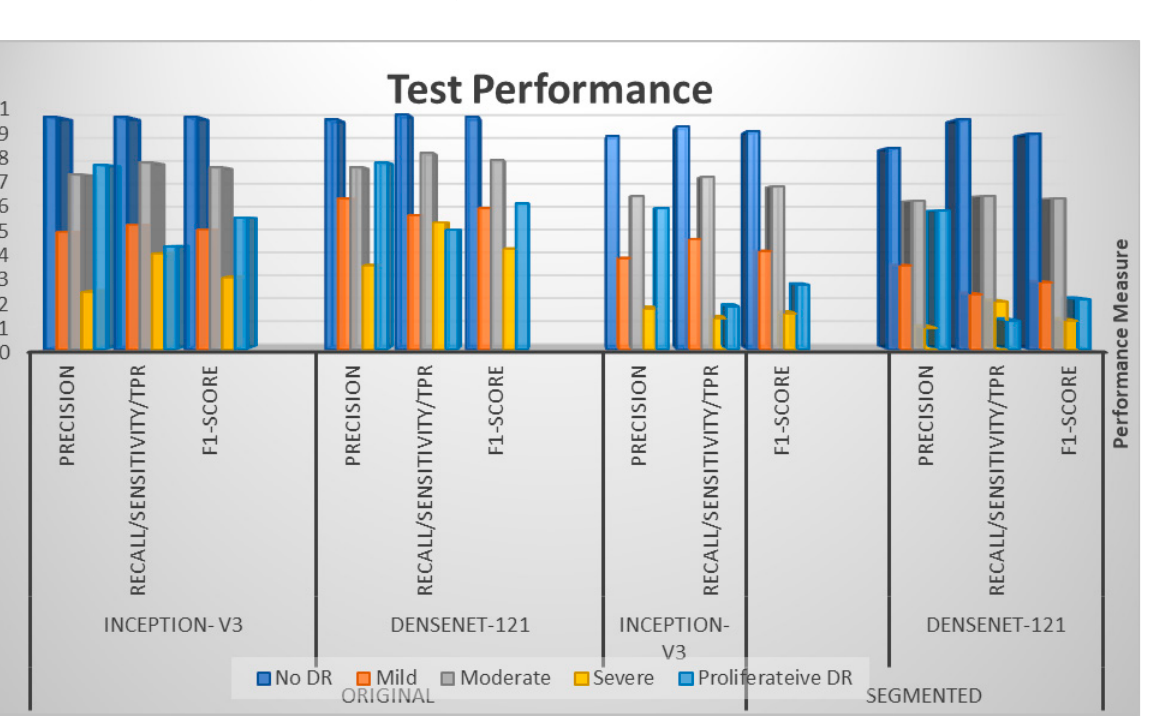
Table 3. Test performance for original and segmented blood vessels.